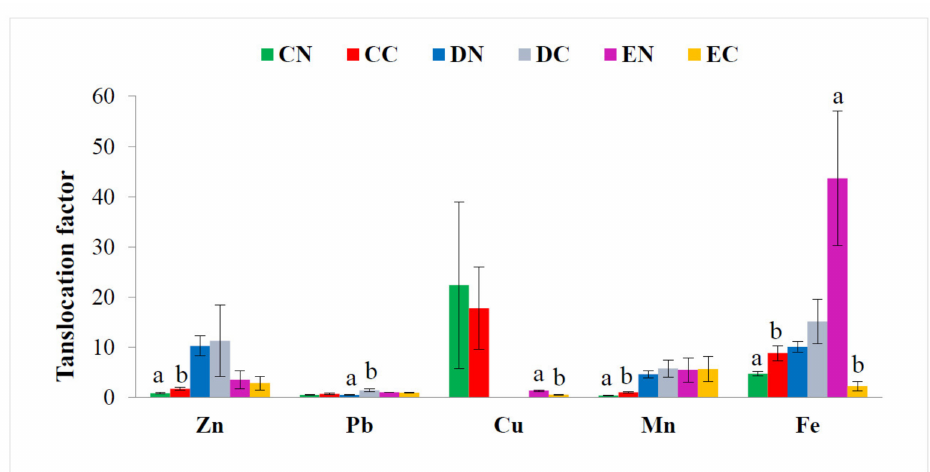
Figure 3. Translocation factor for leaves and roots of C. salviifolius, D. viscosa, and E. pithyusa in contaminated soil (C) and uncontaminated soil (NC). The mean and standard error bars of the mean are indicated. The non-parametric Kruskal-Wallis test was applied. Different letters indicate significant differences at a significance level <0.05 for the same plant growing on contaminated and uncontaminated